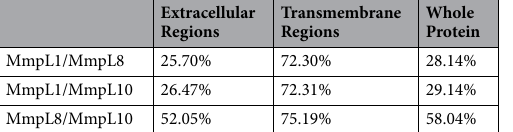
Table 1. Similarity comparison of MmpL1, MmpL8 and MmpL10